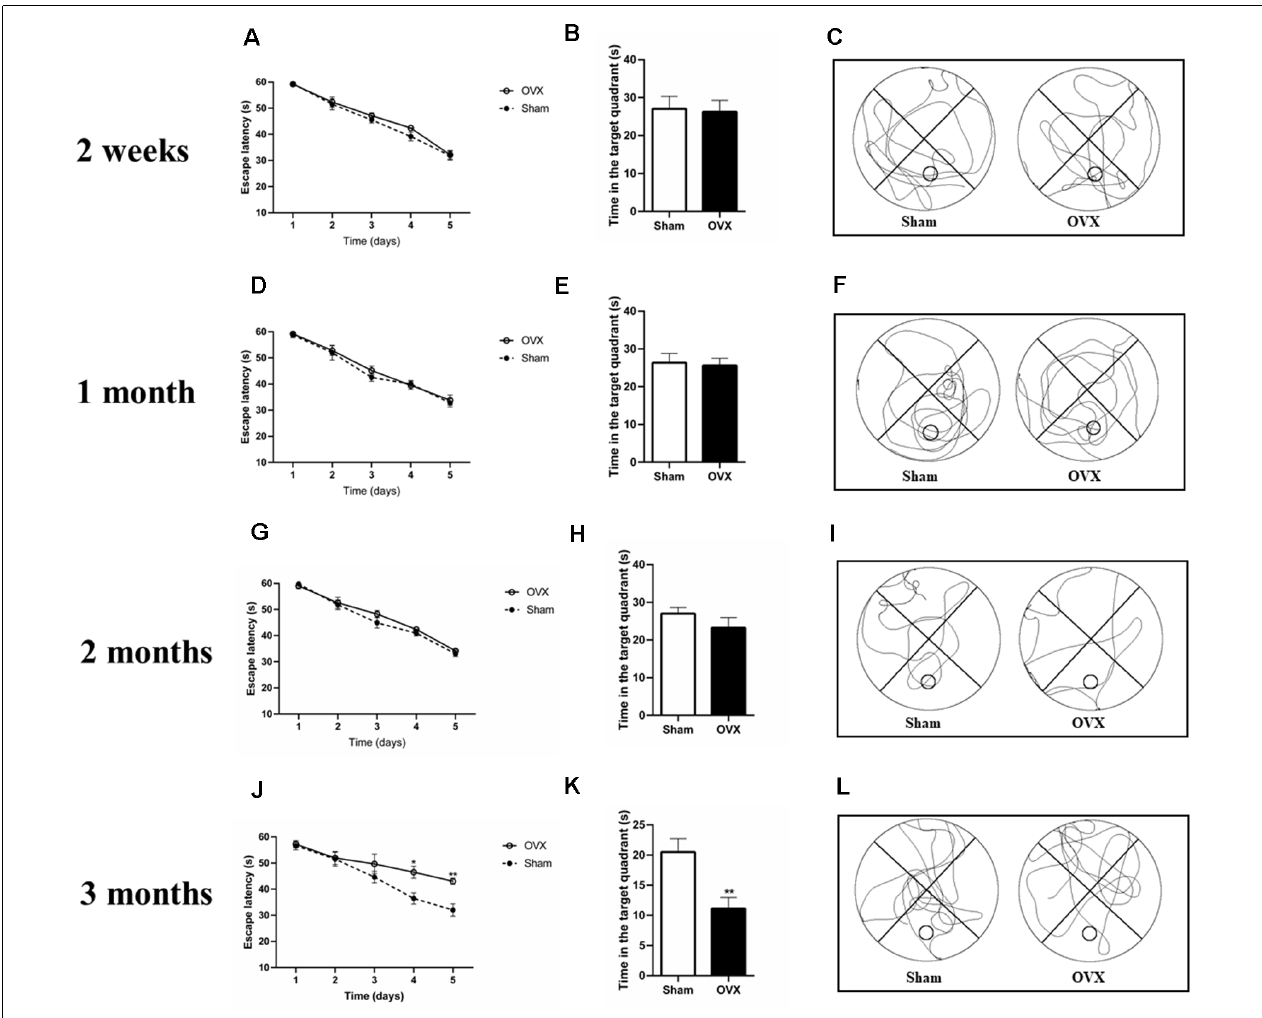
FIGURE 2 | Spatial cognitive impairments in ovariectomized mice (OVX) as measured in the Morris water maze test. (A,D,G,J) Escape latency. (B,E,H,K) Time spent in the target quadrant. (C,F,I,L) Representative animal trajectories during 60 s on day six. The circle in a lower quadrant marks the original placement on the platform. Bars represent mean values ± standard error of the mean (SEM). * p < 0.05, ** p < 0.01 compared with the Sham group at the same timepoint ( n =